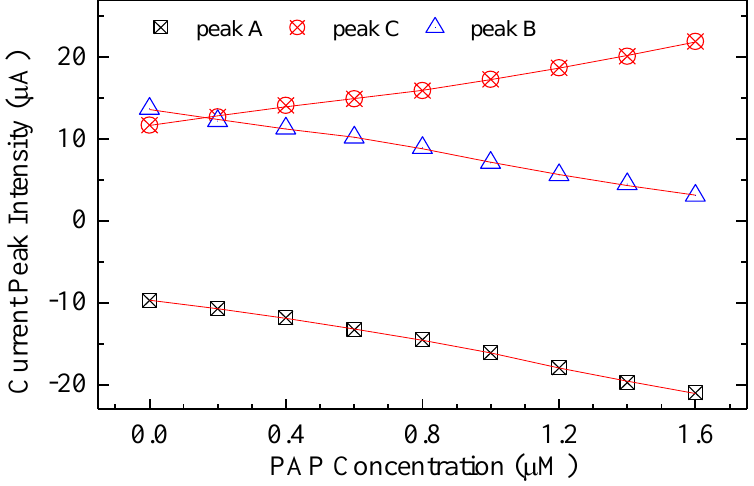
Figure 8. Intensity of the current peaks (identified as A, B and C in the plot of Figure 7, from which data are extracted) of a typical Au/Nafion/MWNTs-Nafion:Cu/Au, as a function of the PAP